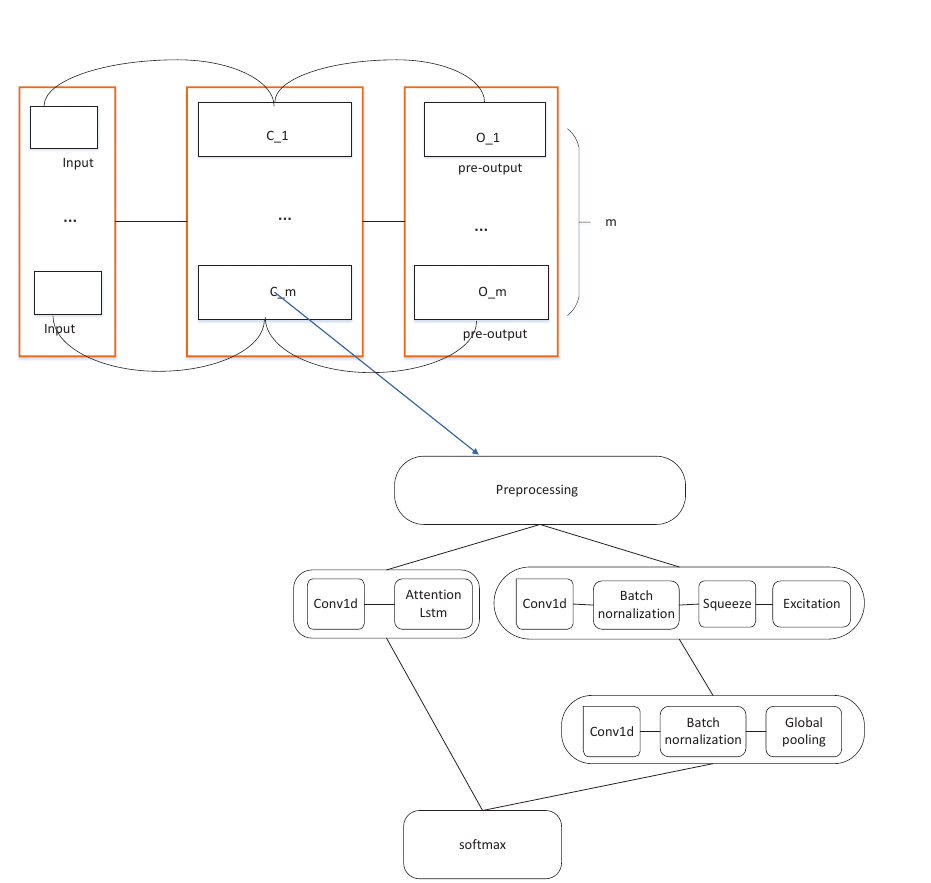
Figure 3. Structure of the proposed P system for time-series anomaly